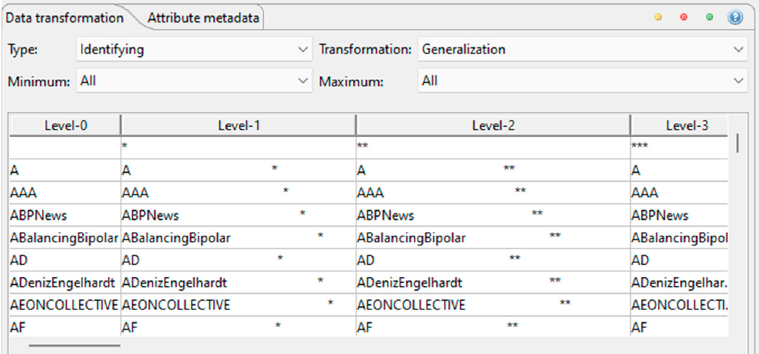
Figure 6. Hierarchy username.